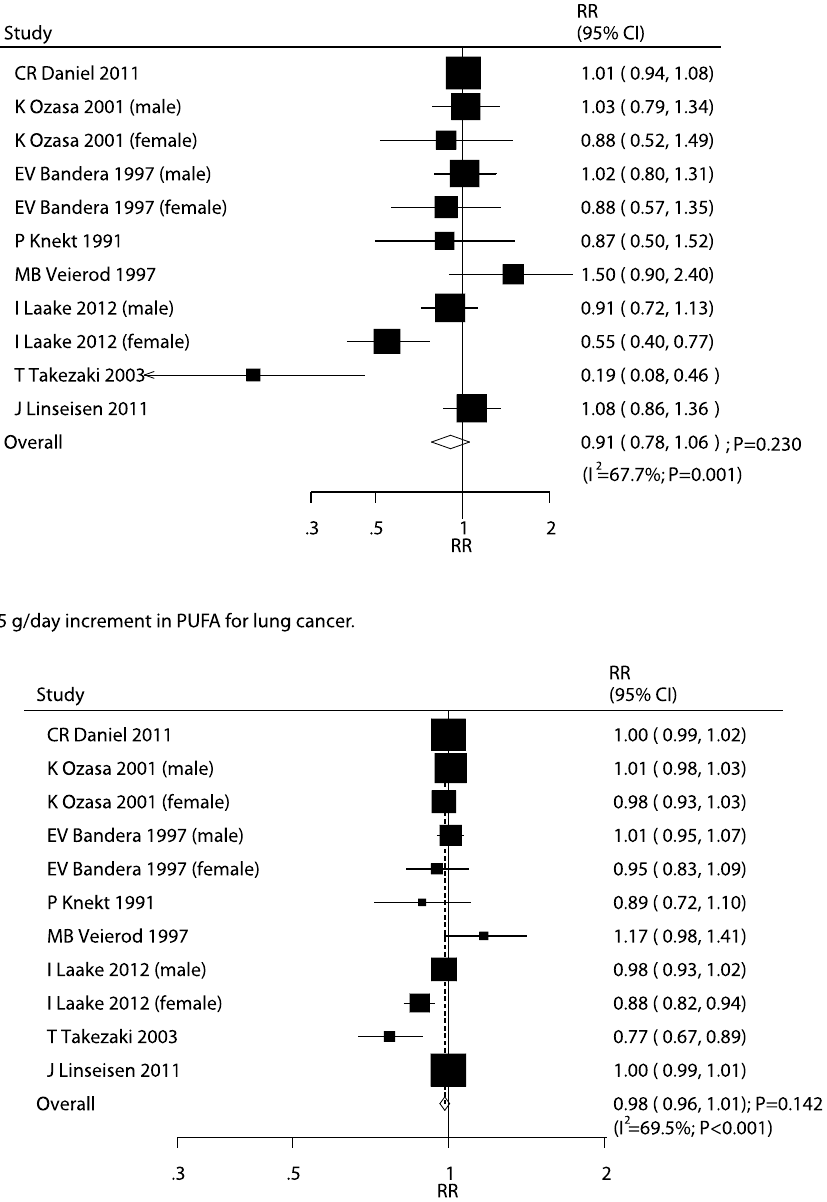
Figure 2. Relative risk estimates of lung cancer for high versus low PUFA intake (A); Dose-response meta-analysis for per 5 g/day increment in PUFA intake for lung cancer